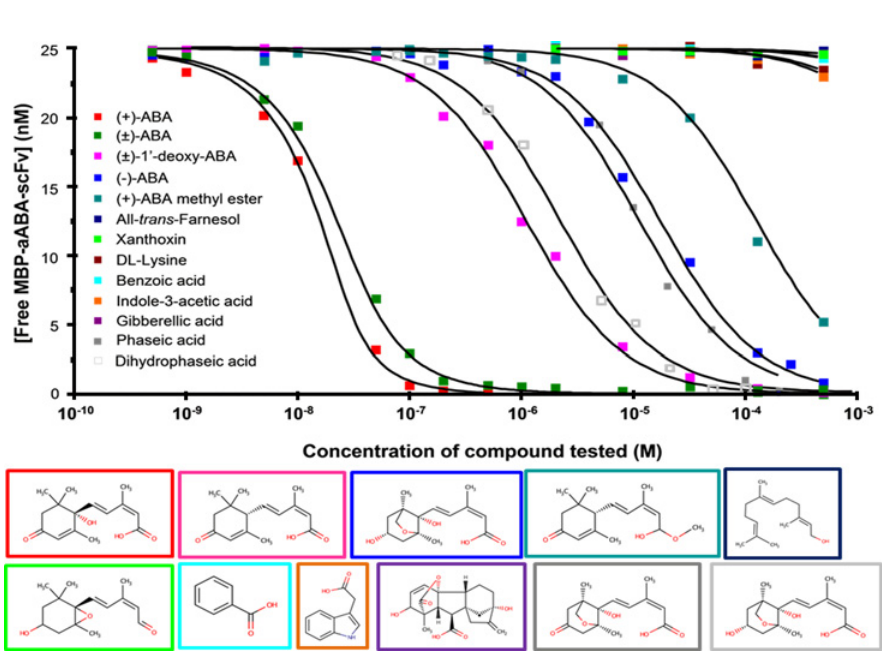
Fig 4. Cross-reactivity of the anti-ABA-scFv. MBP-antiABA-scFv (25 nM) was mixed with different concentrations of each test compound for 1 hour at 25°C. The concentration of free scFv in the equilibrium mixtures was plotted against the concentration of test compound. The structures of each competitor are shown framed in the same colours as the data in the dose graph. There is no box for the racemic mix. The colour code for each compound is shown on the left of the